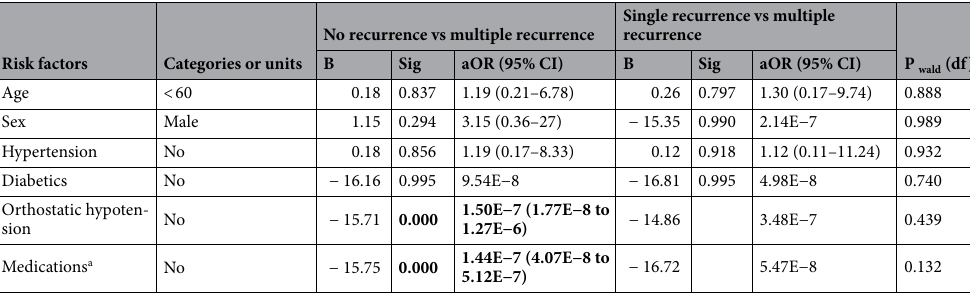
Table 3. Comparison of adjusted risks of BPPV recurrence among no recurrence, single recurrence, and multiple recurrence groups. BPPV Benign paroxysmal positional vertigo, B unstandardized coefficient. Sig. significance probability, aOR adjusted odds ratio, CI confidence interval, df degrees of freedom. a The diseases of the drug-taking were arrhythmia, heart disease, antidepressant, thyroid disease, hypnotic and prostate disease. p values were calculated using polychotomous logistic regression analysis or Wald test. Bold values indicate statistical significance (p <